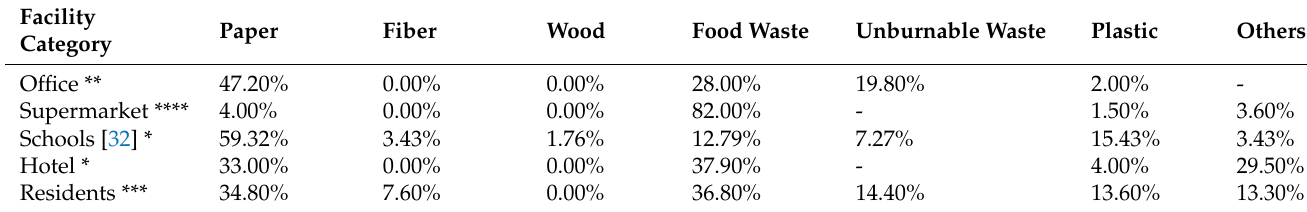
Table 3. Parameter of waste category in each